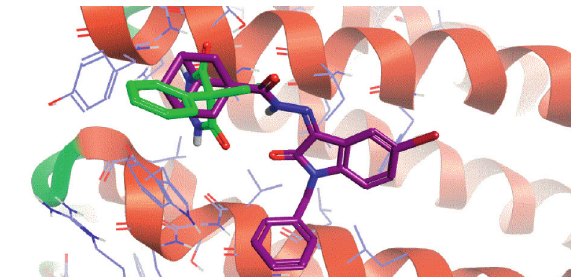
Figure 5: 3D interaction of the GABA barbital and compound 23; phenobarbitone: green color; com- pound 23: violet